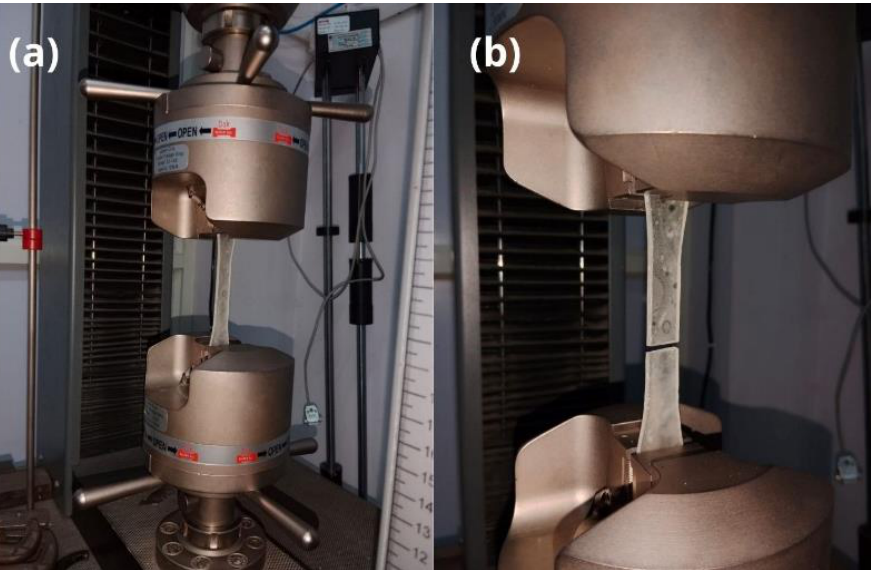
Figure 3. Equipment setup for tensile test specimen in a computerized universal testing machine from DAK system incorporation, ( a ) tensile specimen in a fixture, ( b ) fractured tensile specimen.